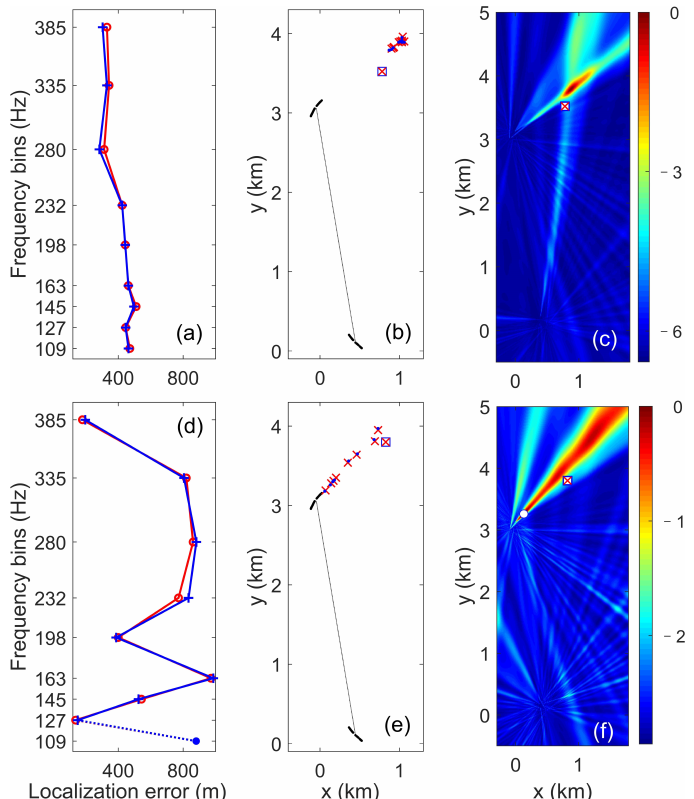
Figure 9. (Color online) Localization results of GMA and N-MUSIC at segment 18 (first row) and segment 20 (second row). ( a , d ) Localization errors with nine tone frequencies of GMA (solid red line with red circles) and N-MUSIC (solid blue line with plus symbols). ( b , e ) Position estimates of GMA (red symbols) and N-MUSIC (blue symbols). True source position is indicated by red cross symbol inside the square. ( c , f ) Spatial spectra of N-MUSIC with 280 Hz. Note that the estimation error of GMA and N-MUSIC at segment 20 with 109 Hz are 1728 m and 1750 m. They are indicated by filled red circle and filled blue circle in ( d ) respectively.